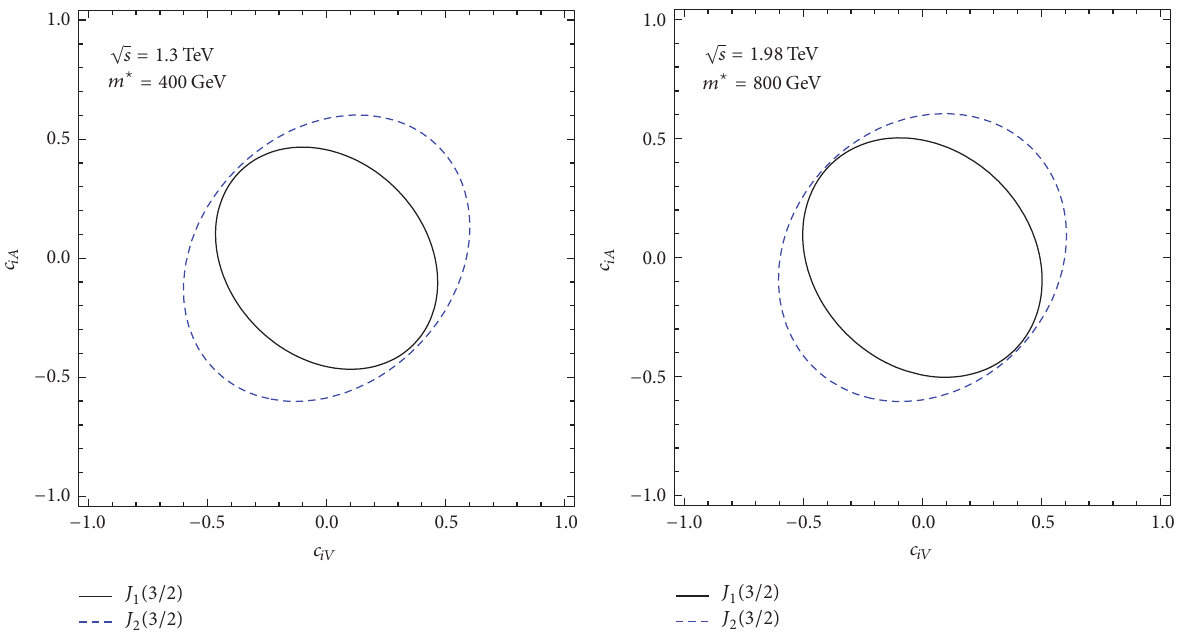
Figure 8: Contour plots for excited spin-3/2 neutrinos for the 𝐽 1 and 𝐽 2